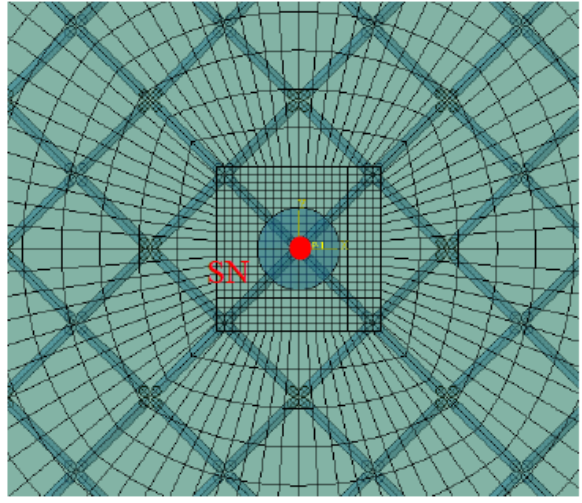
Figure 3: The impact location during impact tests.